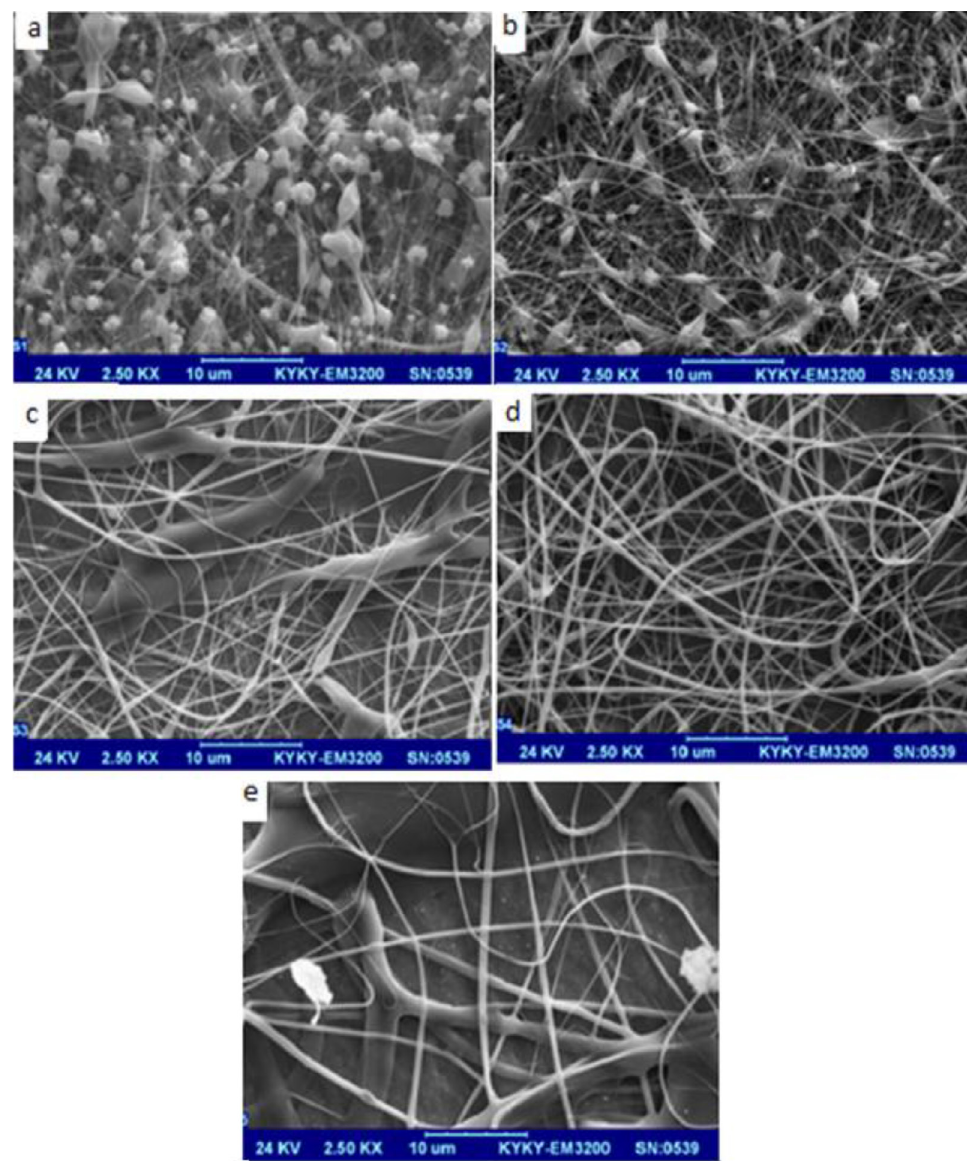
Fig.1. SEM images of as-spun CA fiber mats from different amount of CA solution in 3:1 (v/v) acetone/DMF. Field strength: 30 KV/8